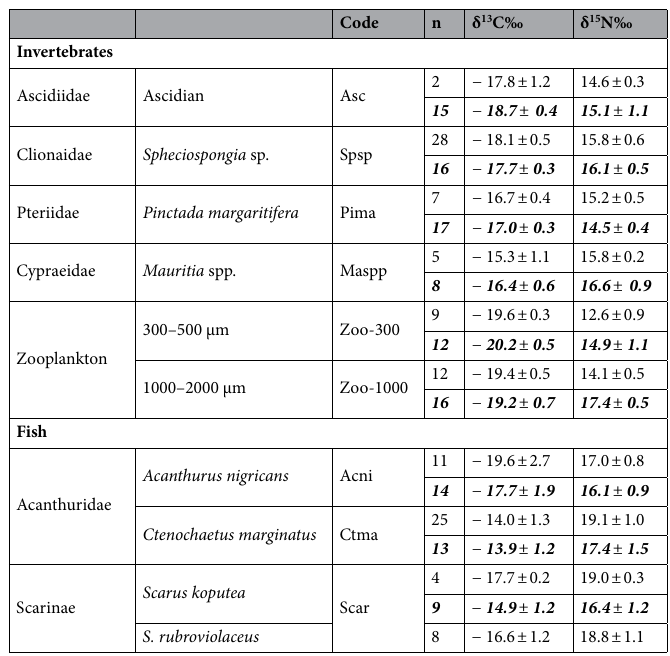
Table 1. Bulk δ 13 C and δ 15 N values (means ± standard deviation) of nine selected primary consumers. Summer with bold italic, winter without bold